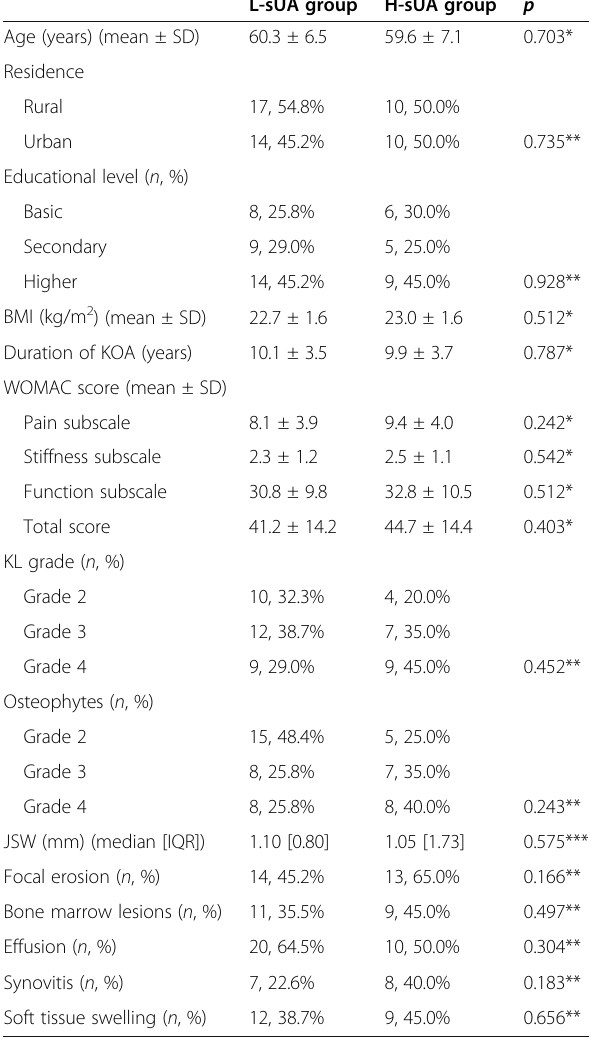
Table 3 Comparison of socio-demographic characteristics, clinical findings, and radiological findings between male knee osteoarthritis patients in low serum uric acid group versus high serum uric acid